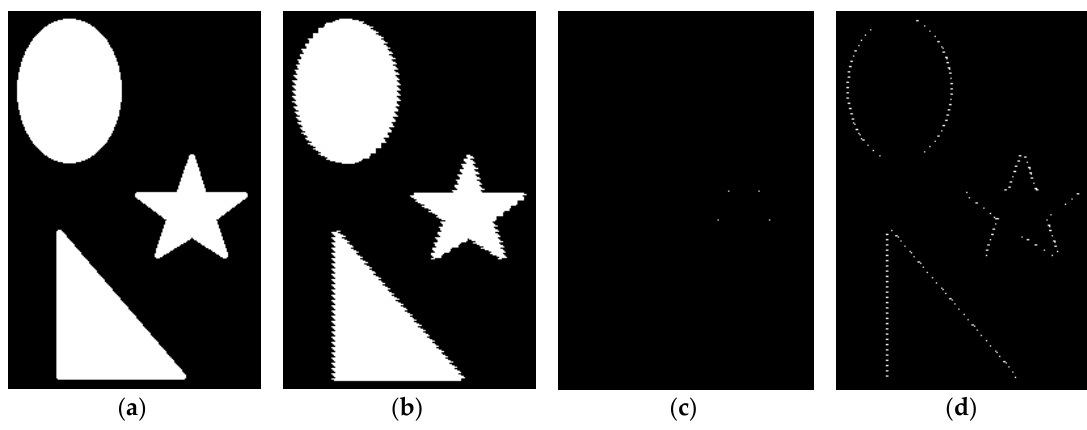
Figure 11. Application of bothat to a binary image: ( a ) initial image; ( b ) image with shifted rows; ( c ) bothat applied to the initial image; ( d ) bothat applied to the image with shifted rows.